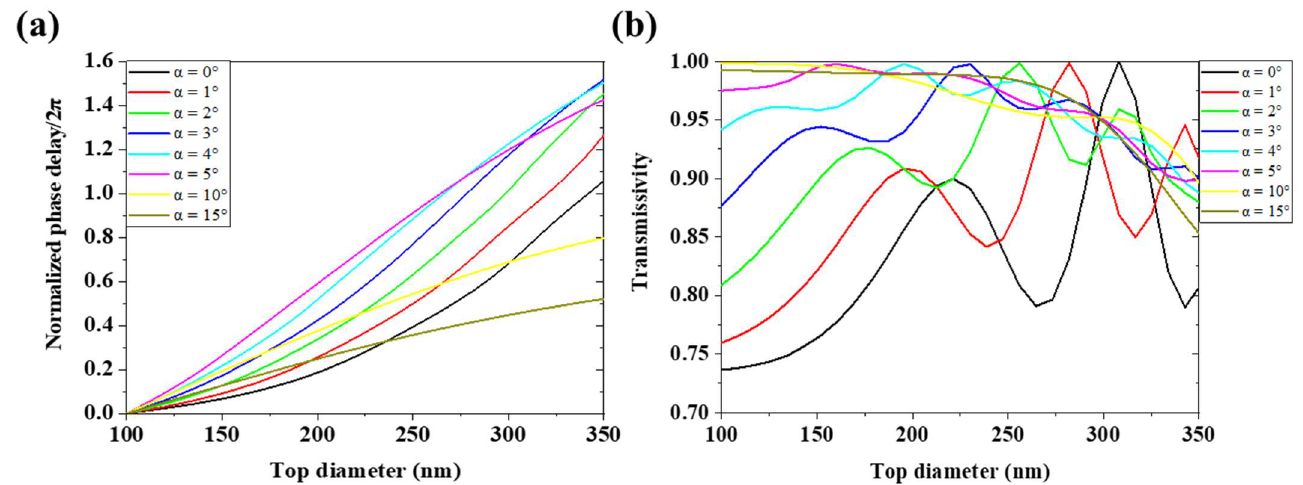
Figure 5. Simulation results of units with different values of α. ( a ) Relationship between D and phase shift. ( b ) Relationship between D and transmissivity.